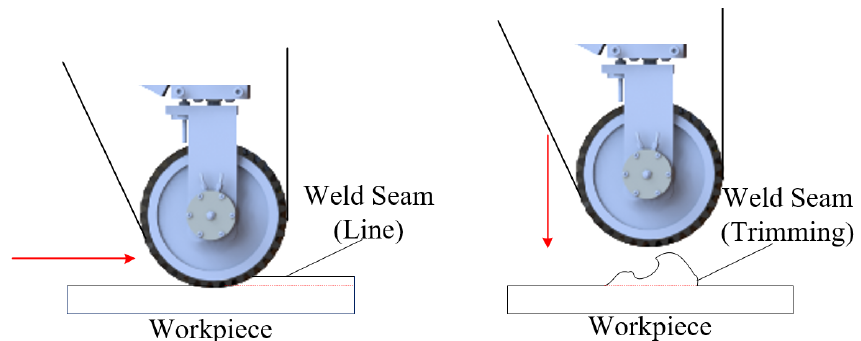
Figure 5. Weld seam grinding